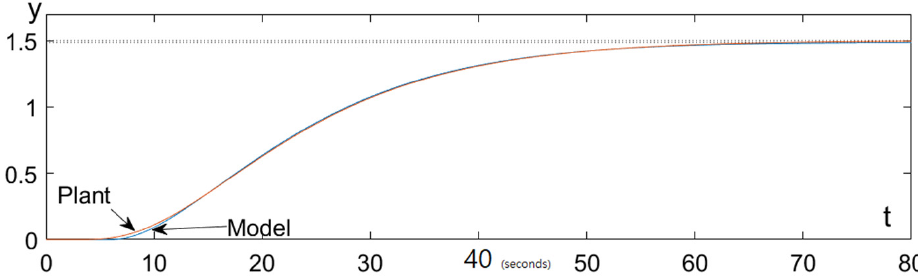
Figure 6. Step responses of the plant from example 4 and its model.